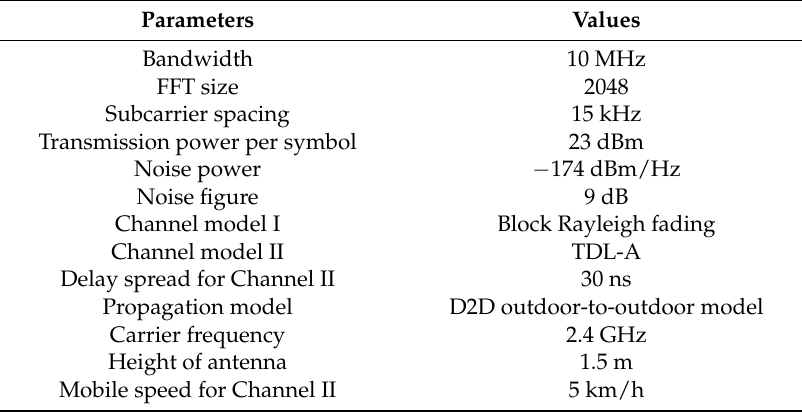
Table 1. Evaluation